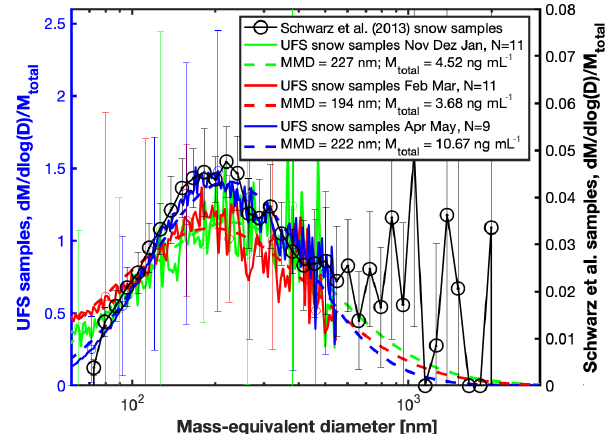
Figure 6. BC mass size distributions of the snow samples de- duced from the SP2 measurements. The size distributions are aver- aged over the three periods November–December–January (green), February–March (red), and April–May (blue) and are normalized by the total mass ( M total ). Lognormal fits are represented by the dashed lines. Fit results in terms of mass median diameter (MMD) and integrated mass ( M total ) are given in the legend. An averaged size distribution for fresh snow samples published by Schwarz et al. (2013) is shown for comparison (black line and open